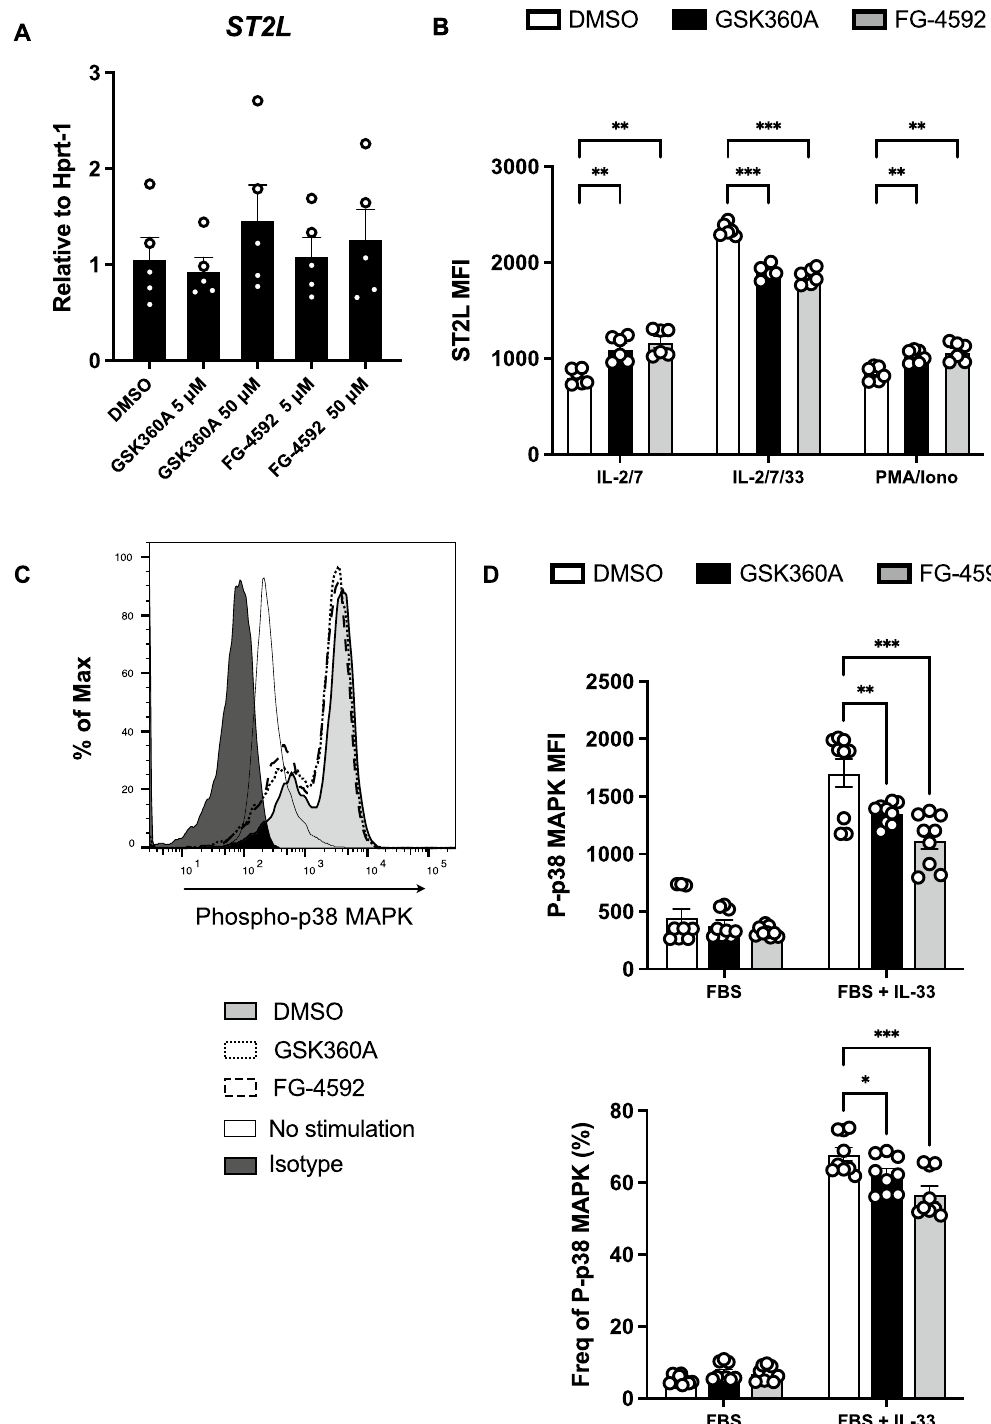
Figure 3. IL-33-ST2L-p38 MAPK signaling was impeded in kidney ILC2s treated with HIF-PHD inhibitors. ( A ) ILC2s were sorted from kidneys of pooled 6 mice, and cultured with IL-2 and IL-7 for 3 days. Then IL-33 was added to stimulate ILC2s for further 3 days, and HIF-PHD inhibitors were added for the last 24 h. Relative levels of mRNA expression for ST2L in kidney ILC2s treated with DMSO, GSK360A, and FG-4592. ( B ) Sorted kidney ILC2s were stimulated by 50 ng/ml recombinant murine IL-33 or 50 ng/ ml PMA and 500 ng/ml ionomycin for 3 h in the presence of brefeldin A. ST2L MFI was analyzed by FACS. ( C ) Sorted kidney ILC2s were cultured with IL-2 and IL-7 for 3 days, and half of the media was changed with fresh media containing IL-2 and IL-7. After a further 3 days, ILC2s were cultured in cytokine-free conditions for 4 h in the presence of HIF-PHD inhibitors, and then ILC2s were stimulated with 10 ng/ml recombinant murine IL-33 for 15 min. Phosphorylated p38 MAPK (Thr180/Tyr182) was assessed by FACS. Representative histograms are shown for phosphorylated p38 MAPK in kidney ILC2s treated with DMSO (gray area), GSK360A (dashed line), FG-4592 (long-dashed line), IL-33 non-stimulated (solid line), and isotype control (black area). ( D ) The graph shows the frequency of phosphorylated p38 MAPK. We used the pooled kidney from 6 mice as n = 1, and data shown are pooled from two (A,B) (n = 6) or three (D) (n = 9) independent experiments. Error bars show SEM. * p < 0.05, ** p < 0.01, *** p <